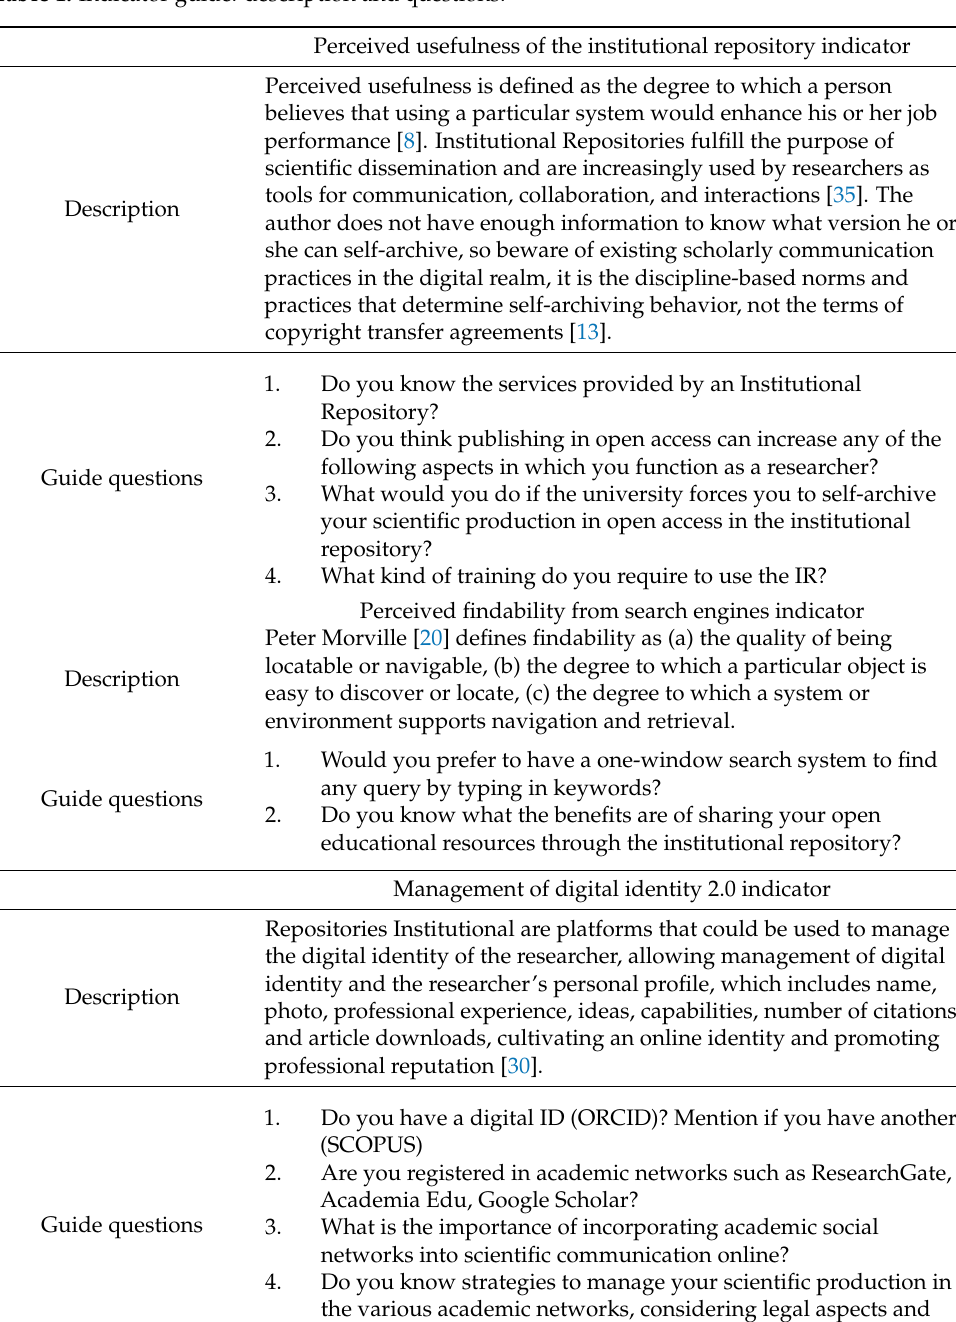
Table 1. Indicator guide: description and